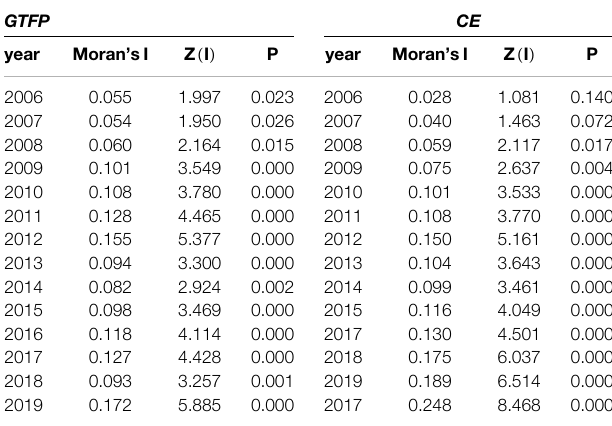
TABLE 3 | Test results of global Moran ’ s index.